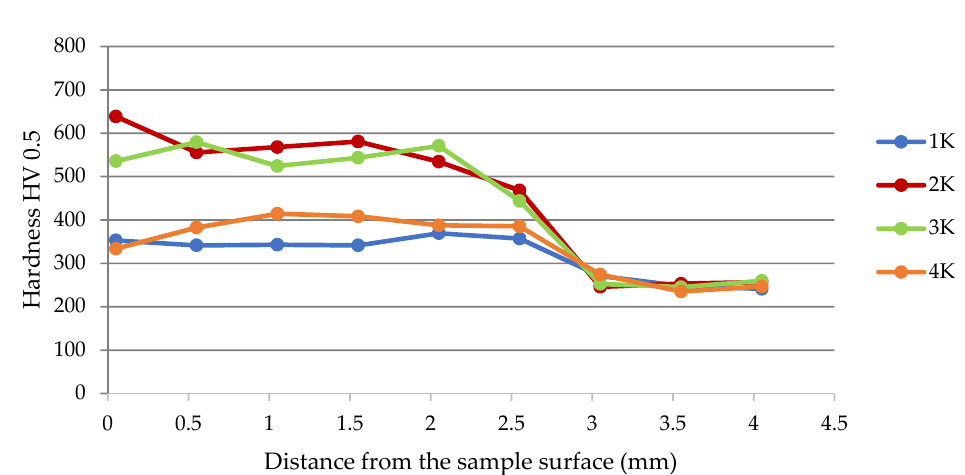
Figure 18. Crankshaft microhardness curves.